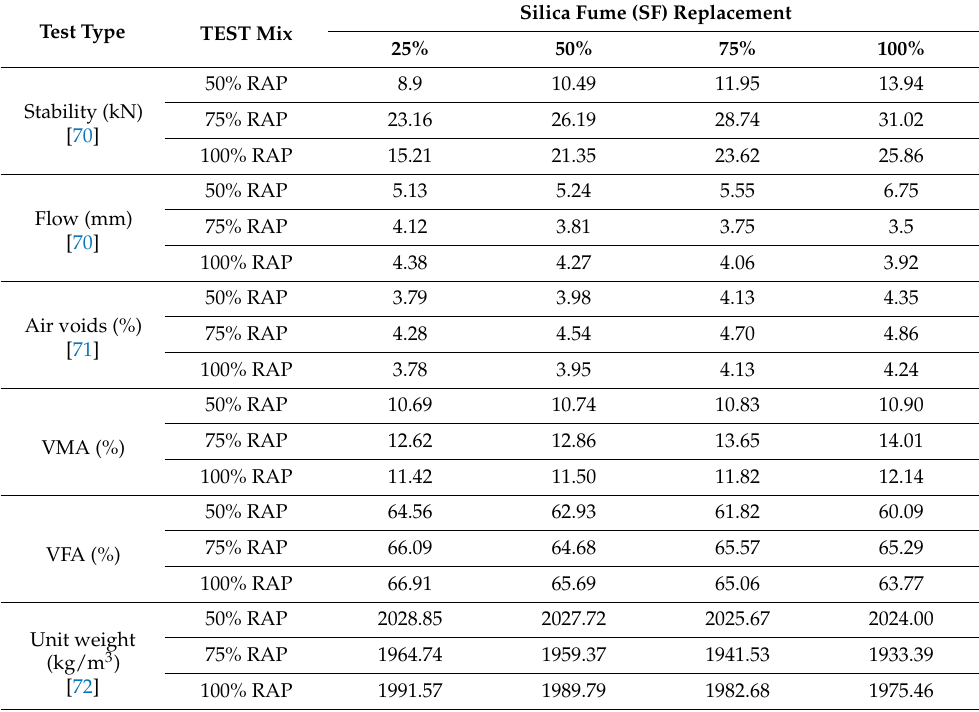
Table 7. Test results for the RAP mixes containing silica